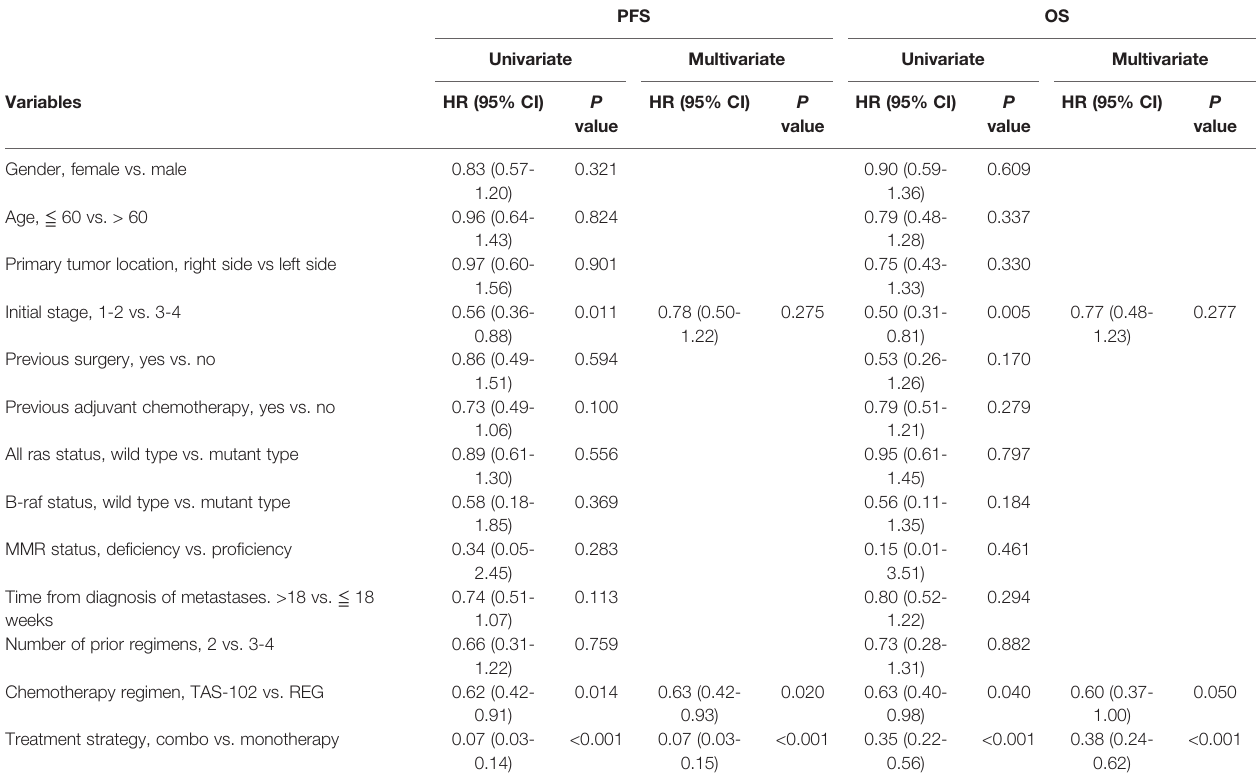
TABLE 3 | Cox regression analysis of parameters associated with survival in mCRC patients treated with TAS-102 or REG. PFS OS Univariate Multivariate Univariate Multivariate